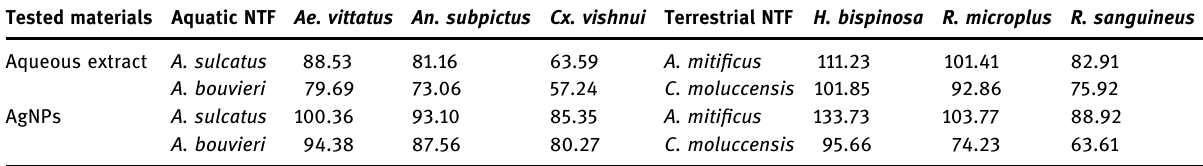
Table 3: SI of aquatic and terrestrial NTF shared over selected BSVs exposed to ALE and synthesized AgNPs of A.